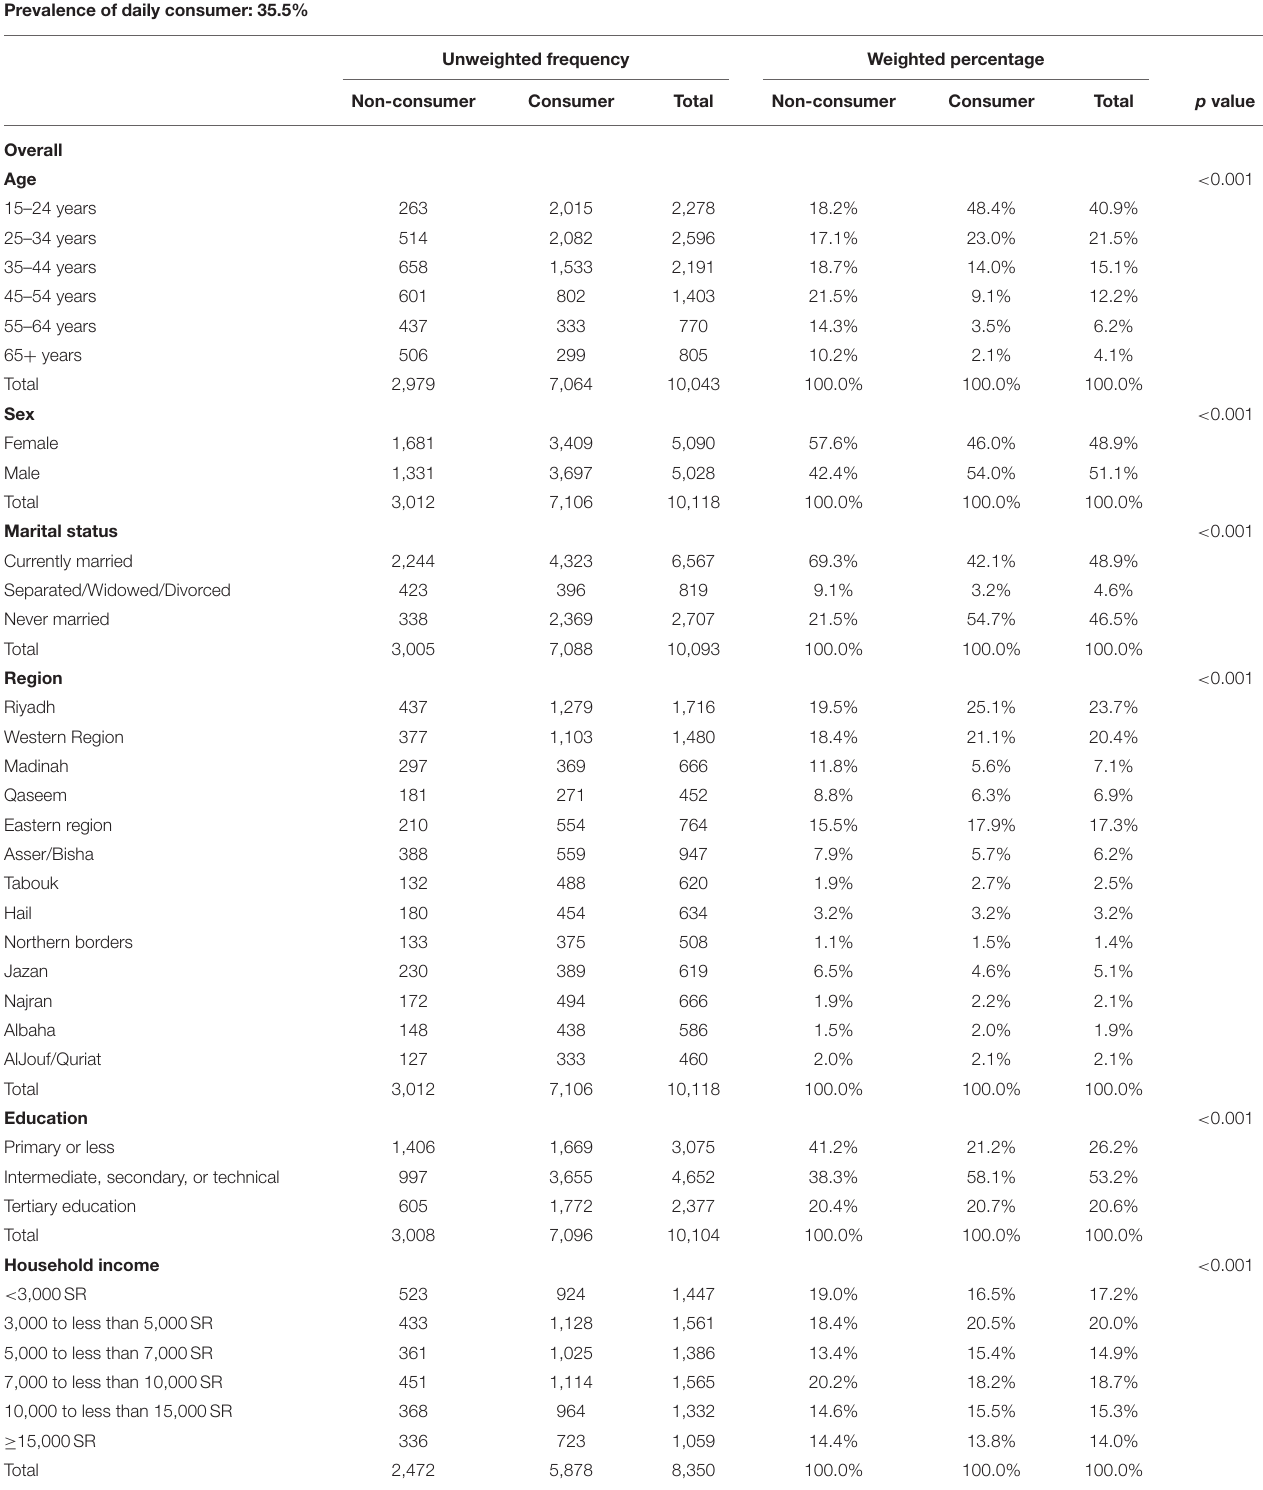
TABLE 2 | Respondent characteristics and sugar-sweetened beverage (SSB) consumption. Prevalence of SSB-consumer: 71.2% Prevalence of daily consumer: